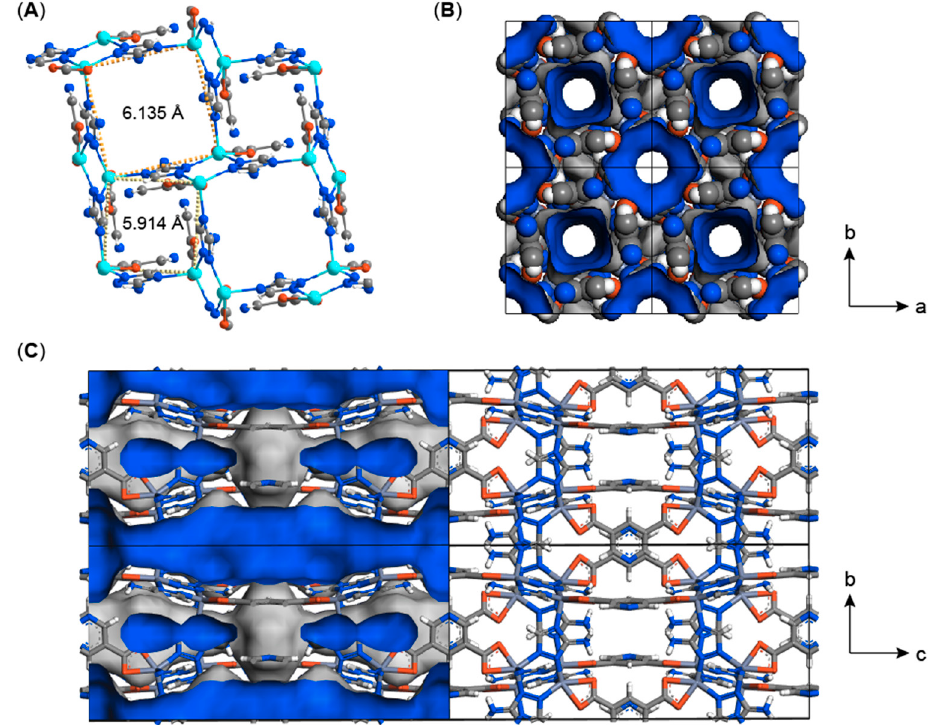
Figure 1. ( A ) Structure of 1 showing the 1D channel with two different dimensions. ( B , C ) Connolly isosurface mapping on 1.